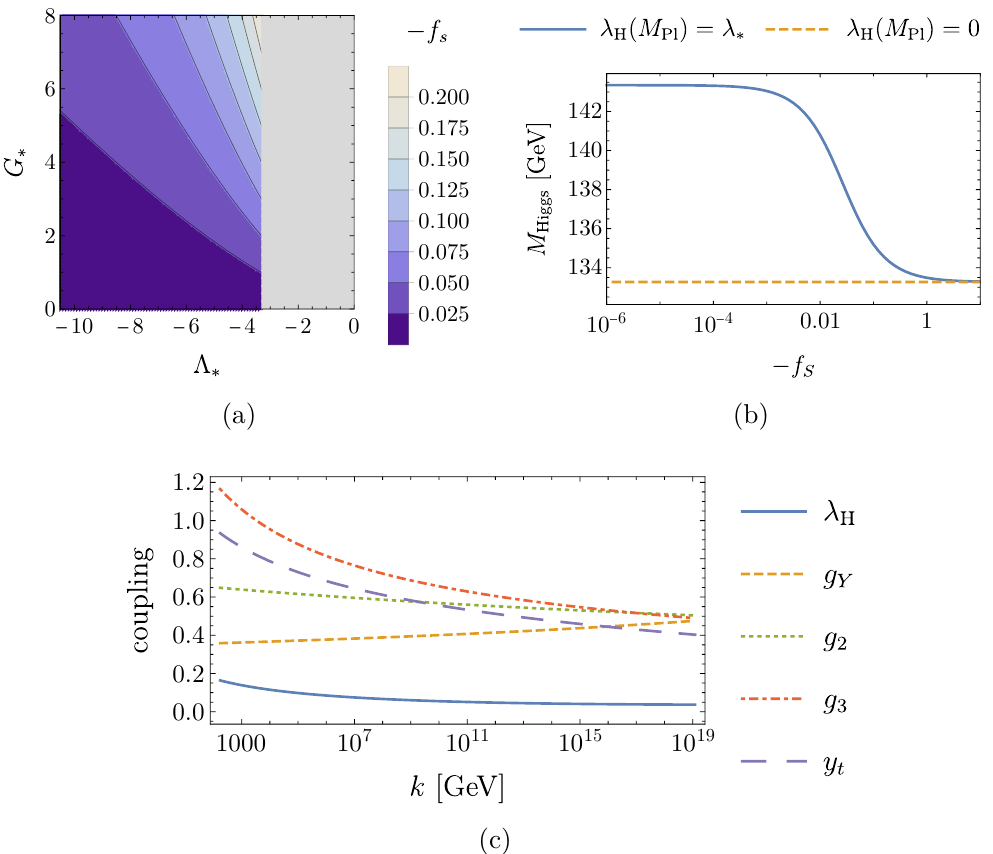
Figure 1 . Here we reverse the RG flow to evolve the IR values for the SM couplings to the scale M Pl using the SM one-loop beta functions, implement the fixed point condition (3.10) for λ H and evolve the Higgs quartic coupling to IR scales. (a) Contours of the quantity f gravitational contributions to β as a function of gravitational couplings ( G λ H is excluded because it could result in a vanishing top mass, as found within an approximation in